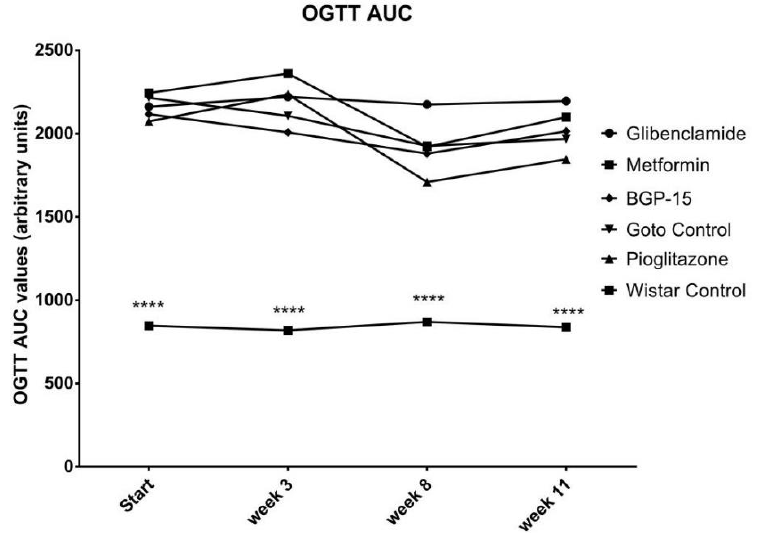
Figure 5. Area Under the Curve (AUC) of blood glucose values measured during Oral Glucose Tolerancy Tests (OGTT). Data is presented as group mean. For a better visibility, standard error of the mean (SEM) of each data points are not plotted. n = 6 animals in each group. **** p < 0.0001 compared to all other groups. Statistical analysis was done using GraphPad Prism: data was analysed with two-way analysis of variance (ANOVA) test.